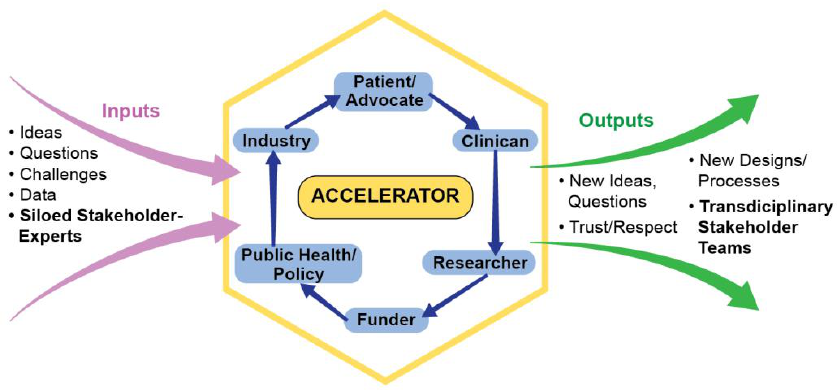
Figure 1. Accelerator model powered by team science.